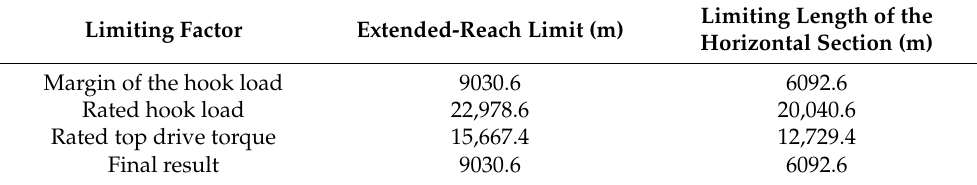
Table 3. Mechanical extended-reach limit of the conventional drilling.